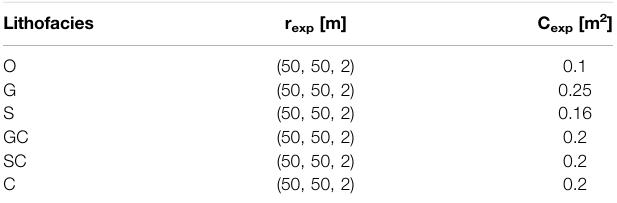
TABLE4| Covariancemodelparameters(C:contributionandr:rangesin x , y ,and z directions) used for the property simulations. Subscript exp indicates an exponential covariance